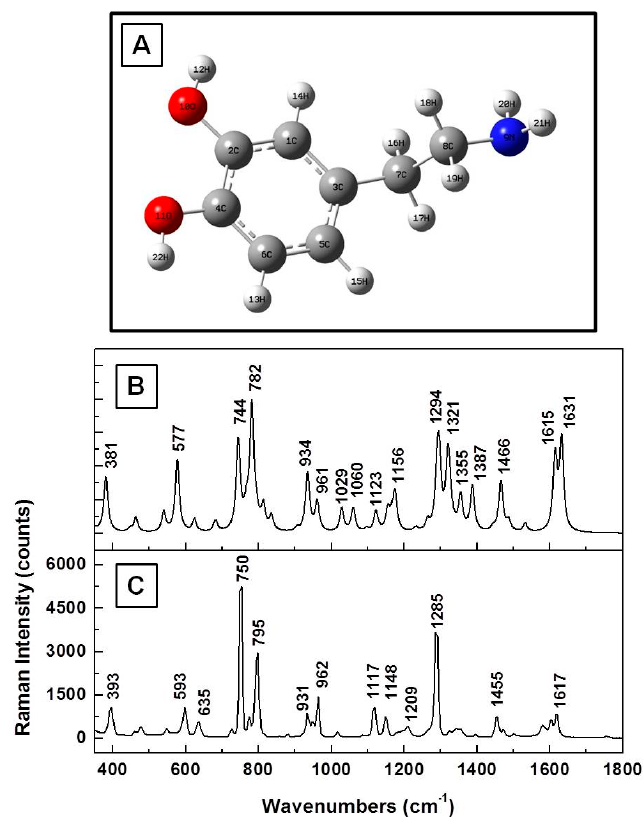
Figure 1. ( A ) Dopamine structural representation in neutral state, DA 0 . Red and blue colors were used for oxygen and nitrogen atoms, respectively; ( B , C ) Theoretically calculated and experimentally measured Raman vibrations of dopamine, respectively. The Raman spectrum was recorded for the standard dopamine powder.